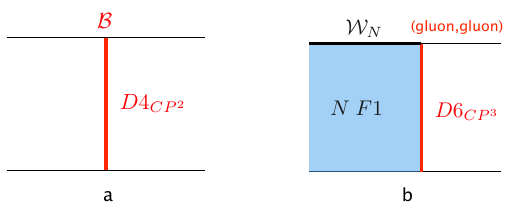
Figure 5 . A holographic description of (a) a baryon, and (b) N Wilson lines being screened by gluons in the SU( N ) k SU( N ) k theory. (cid:2) (cid:0)